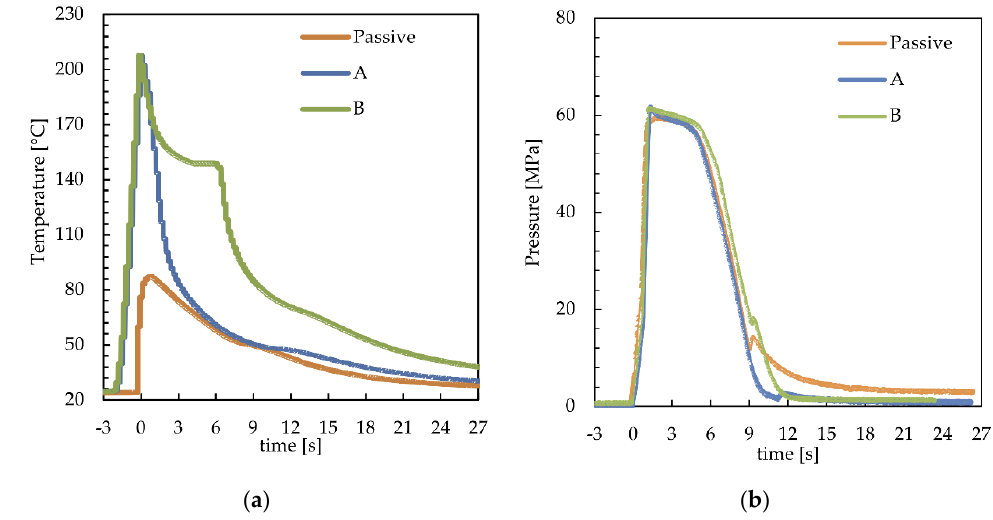
Figure 2. ( a ) Temperature and ( b ) pressure evolutions recorded during injection molding experiments performed with 150 °C cavity surface temperature and different heating times. The temperature and pressure evolution of the passive test were also reported.